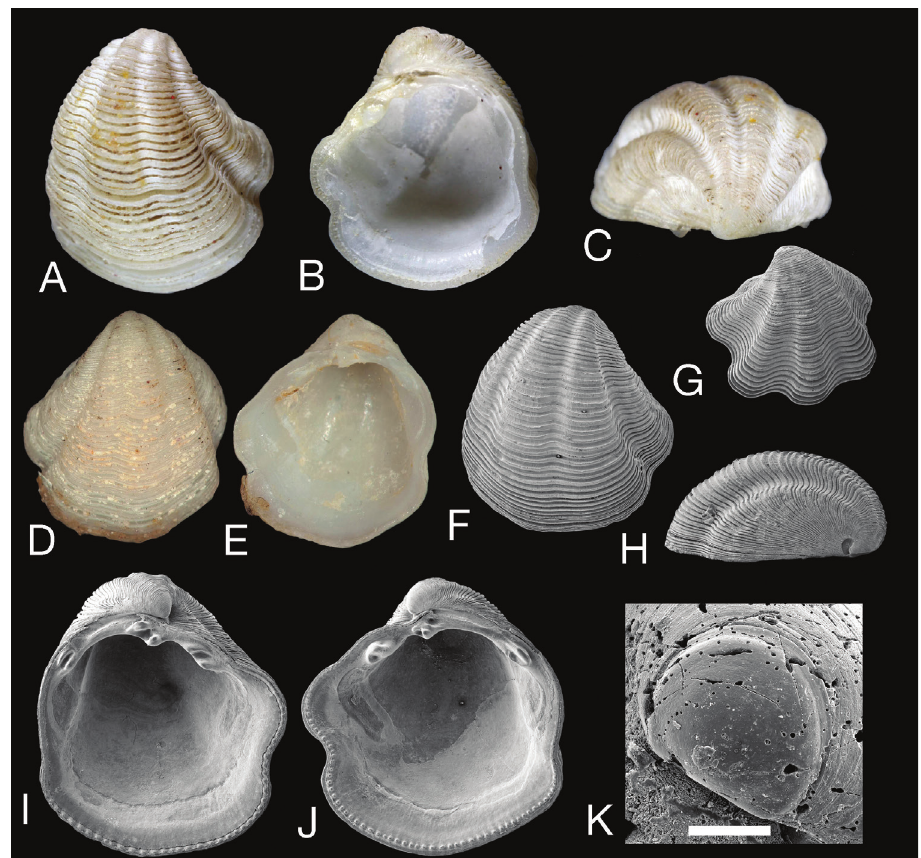
Figure 7. Pleurolucina leucocyma. A–C Lucina leucocyma Dall, 1881 lectotype MCZ 7986, exterior, interior and dorsal view of right valve, L 5.7 mm, H 6.6 mm D , E Lucina leucocyma paralectotype USNM 83140, exterior of left valve and interior of right valve, L 4.8 mm, H 5.5 mm F–K , Pleurolucina leucocyma USNM 446563 Eolis Station 368, off Ajax Reef, Florida F Exterior of left valve, L 5.1 mm G Left valve of juvenile shell, L 3.1 mm H Lateral view of left valve, L 5.1 mm. I Interior of left valve, L 5.5 mm J Interior of right valve, L 5.5 mm K Protoconch, scale bar = 100